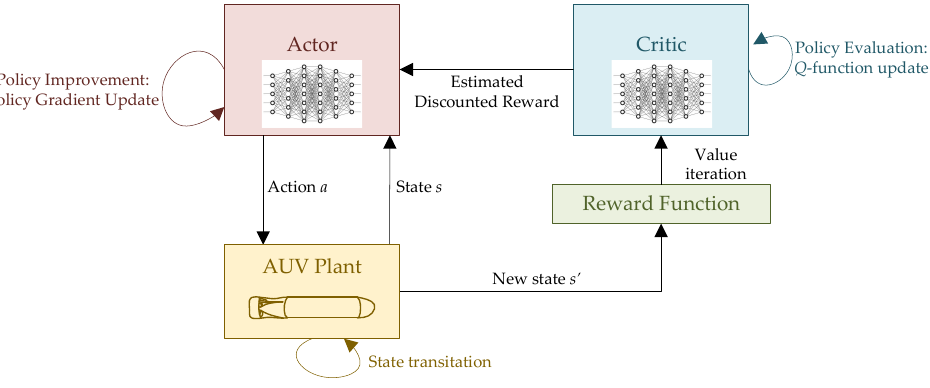
Figure 5. Diagram of the DDPG algorithm for the docking control of an